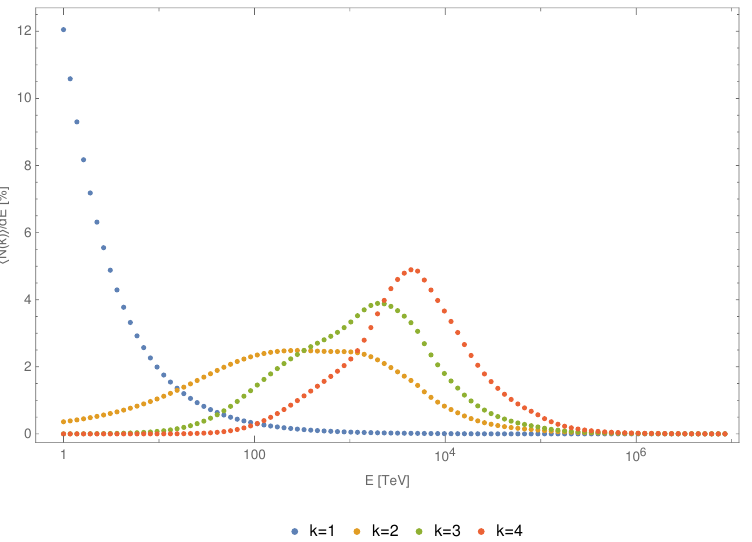
Figure 13. Percent of events per energy range for different number of coincidences k for considered system. This plot was made for model nr 1 with window modification